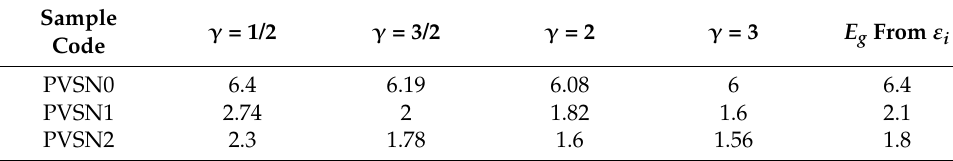
Figure 15. Plot of ( α h υ ) 1/3 vs. h υ for pure PVA and PC films. Table 5. Opticalbandgap from Tauc’smodel and dielectric loss